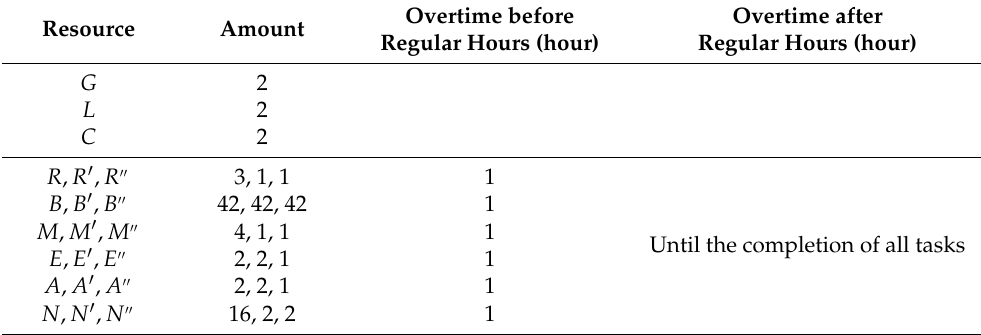
Table 6. Resource